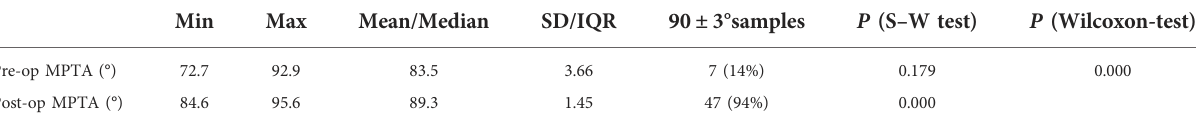
TABLE 4 Pre-operation and post-operation MPTA